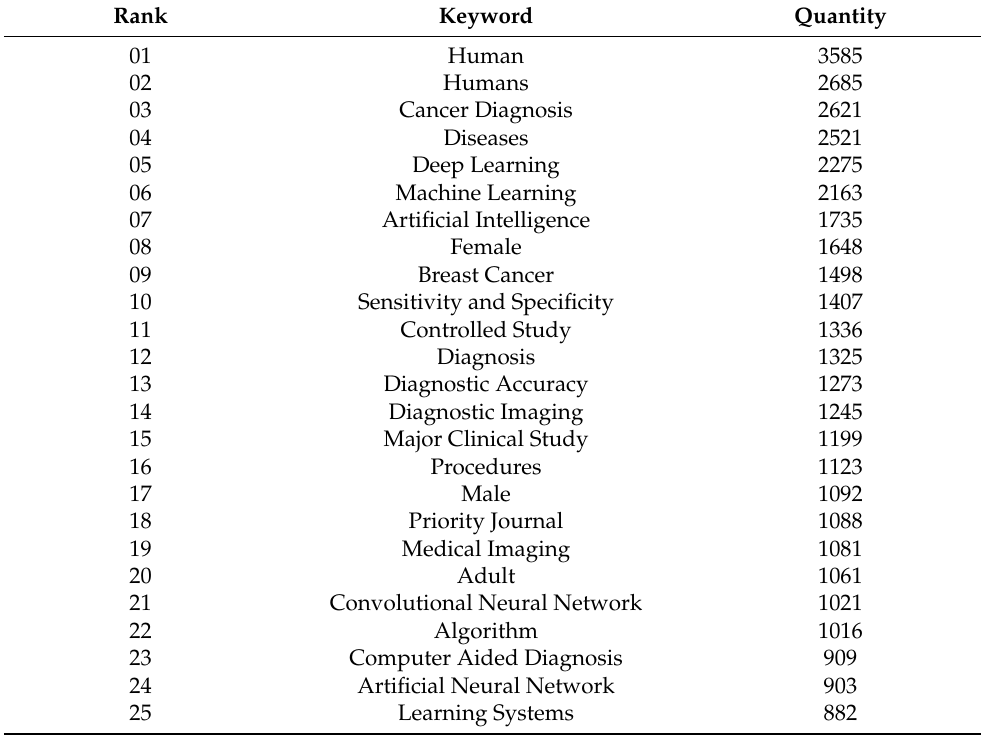
Table 7. Overview of most frequently used